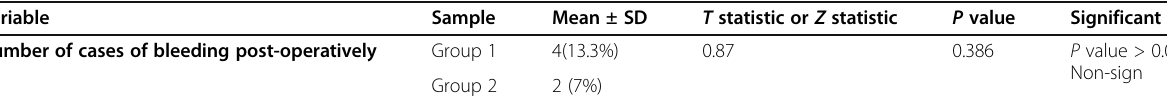
Table 6 The number of patients with bleeding and bleeding starting day post-operatively Variable